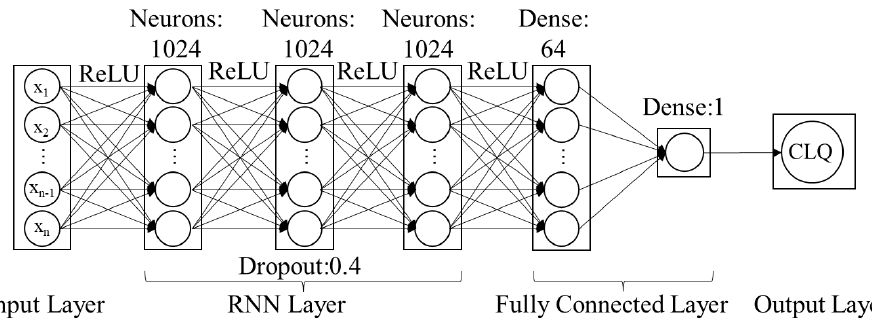
Figure 2. Cultivated land quality evaluation model based on the recurrent neural network.